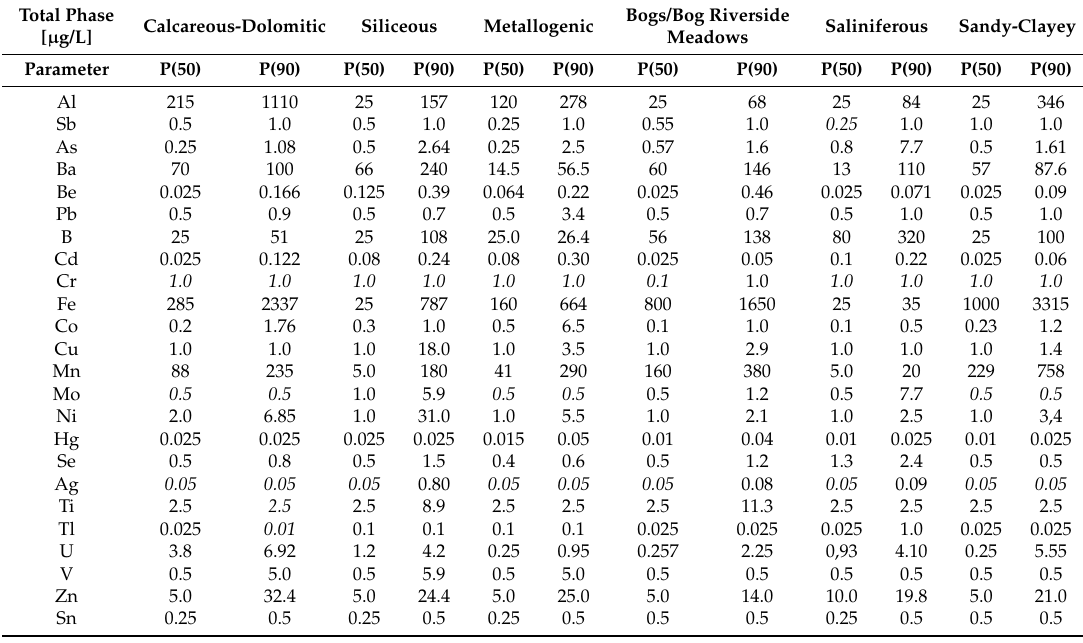
Table 2. Geogenic background concentrations of total metals and metalloids in the rivers of Saxony-Anhalt classified by the aggregated riverine landscapes (pre-selection of data, 50th and 90th percentiles, for all elements the database is n > 20; italics represent data below the detection limit). Total Phase [ µ